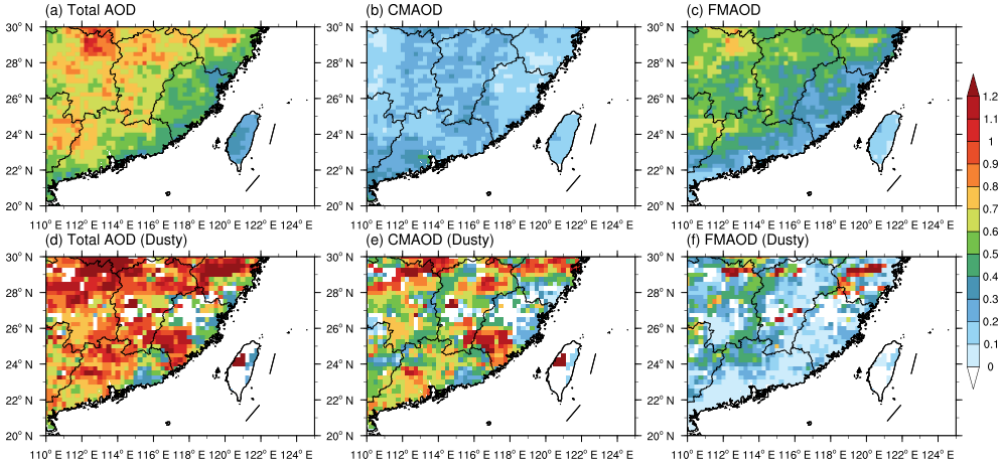
Figure 1. The (a, d) total aerosol optical depth (AOD), (b, e) coarse-mode aerosol optical depth (CMAOD), and (c, f) fine-mode aerosol optical depth (FMAOD) on (a, b, c) all days and (d, e, f) dusty days in June, July, and August (JJA) from 2000 to 2013 using data retrieved from Terra